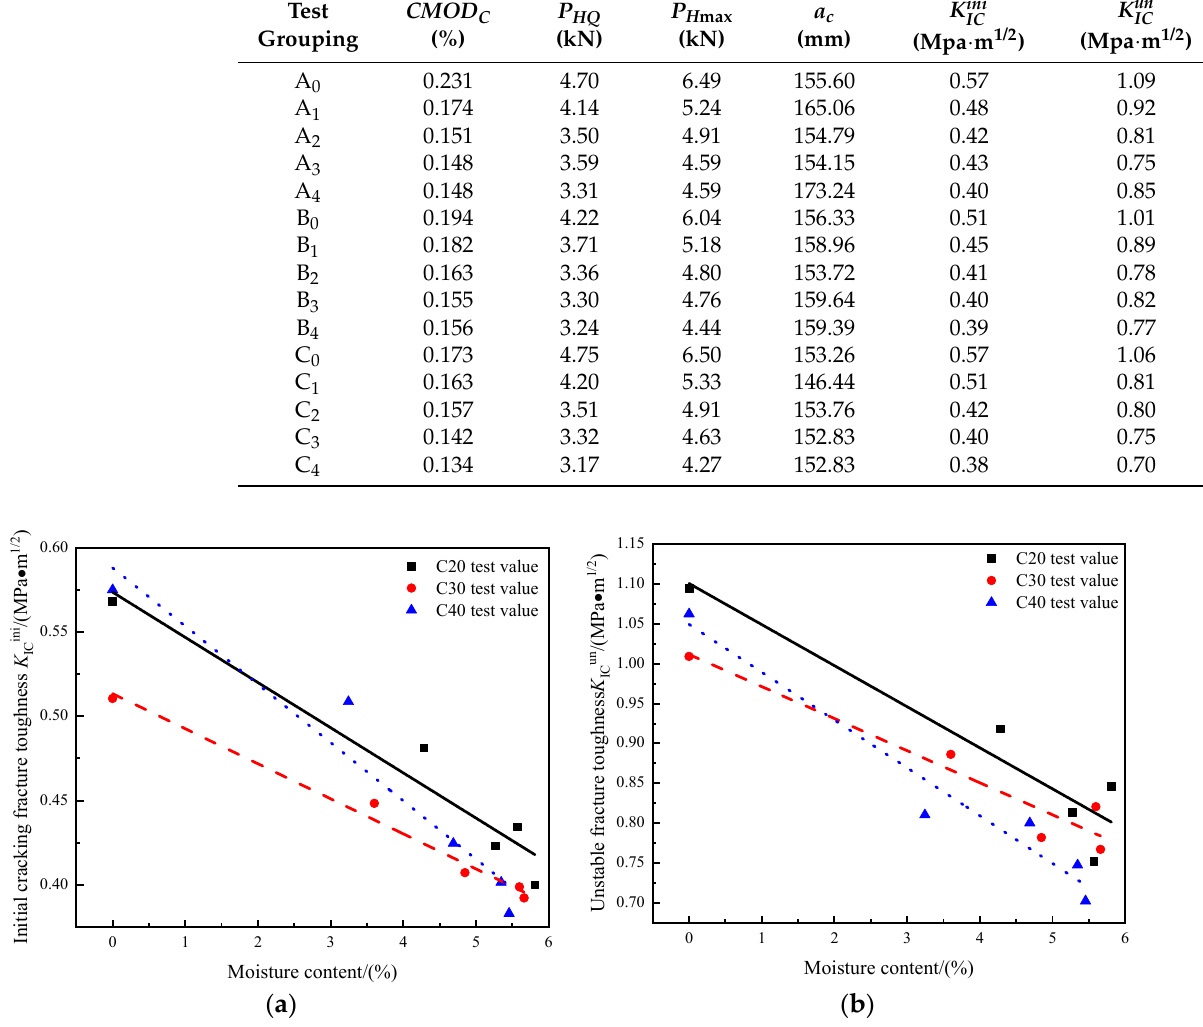
Figure 4. Experimental values of initial cracking fracture toughness and unstable fracture toughness of concrete under different moisture content. ( a ) Initial cracking fracture toughness ( b ) Unstable cracking fracture toughness.